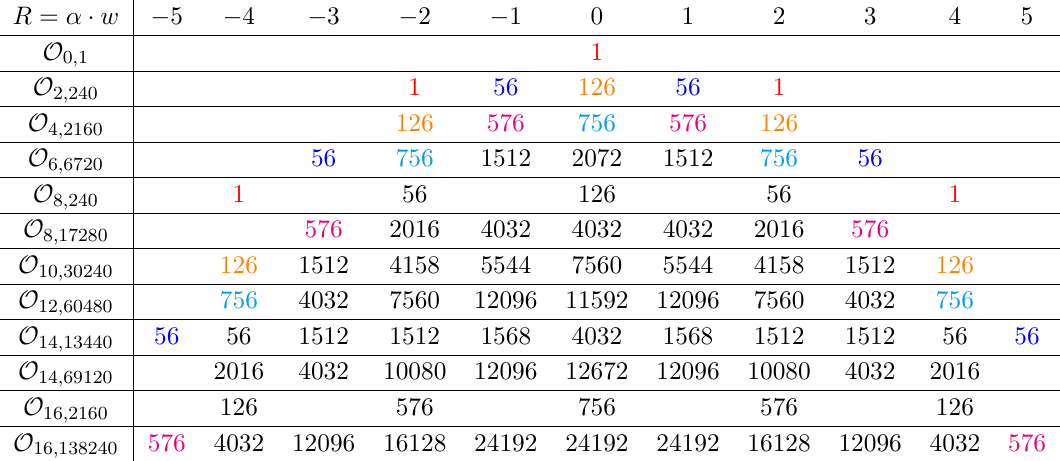
Table 8 . Intersection numbers between roots and elements of E 8 Weyl